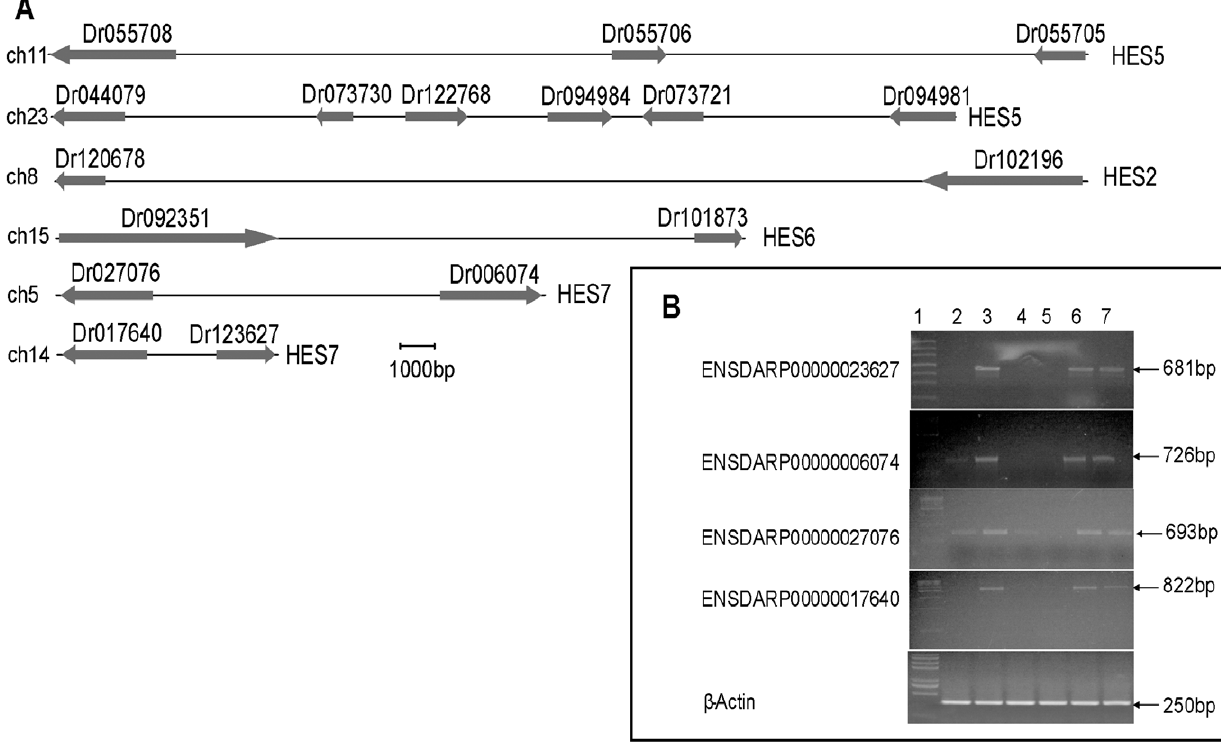
Figure 5. Zebrafish HES/HEY gene loci and expression pattern. (A) The gene loci of the zebrafish HES2, HES6, HES5 and HES7 genes. The arrows towards the right referred the gene on the positive-strand ( + ). The arrows towards the left referred the gene on the negative-strand ( 2 ). We cut short the Ensembl protein ID to reserve the last six digits in this diagram. For example, ENSDARP00000123627 is truncated as Dr123627. (B) Expression of HES7 genes in zebrafish. Transcripts of ENSDARP00000023627, ENSDARP00000006074, ENSDARP00000027076, ENSDARP00000017640 and b -actin were detected by RT-PCR. Lane 1 showed the molecular weight marker of 100 bp ladder. Gene expression patterns were obtained using total RNAs extracted from eye (lane 2), gill (lane 3), female ovary (lane 4), male testis (lanes 5), heart (lanes 6), and liver (lane 7). b -actin was performed to assess quantitative variations in mRNAs among all the samples.